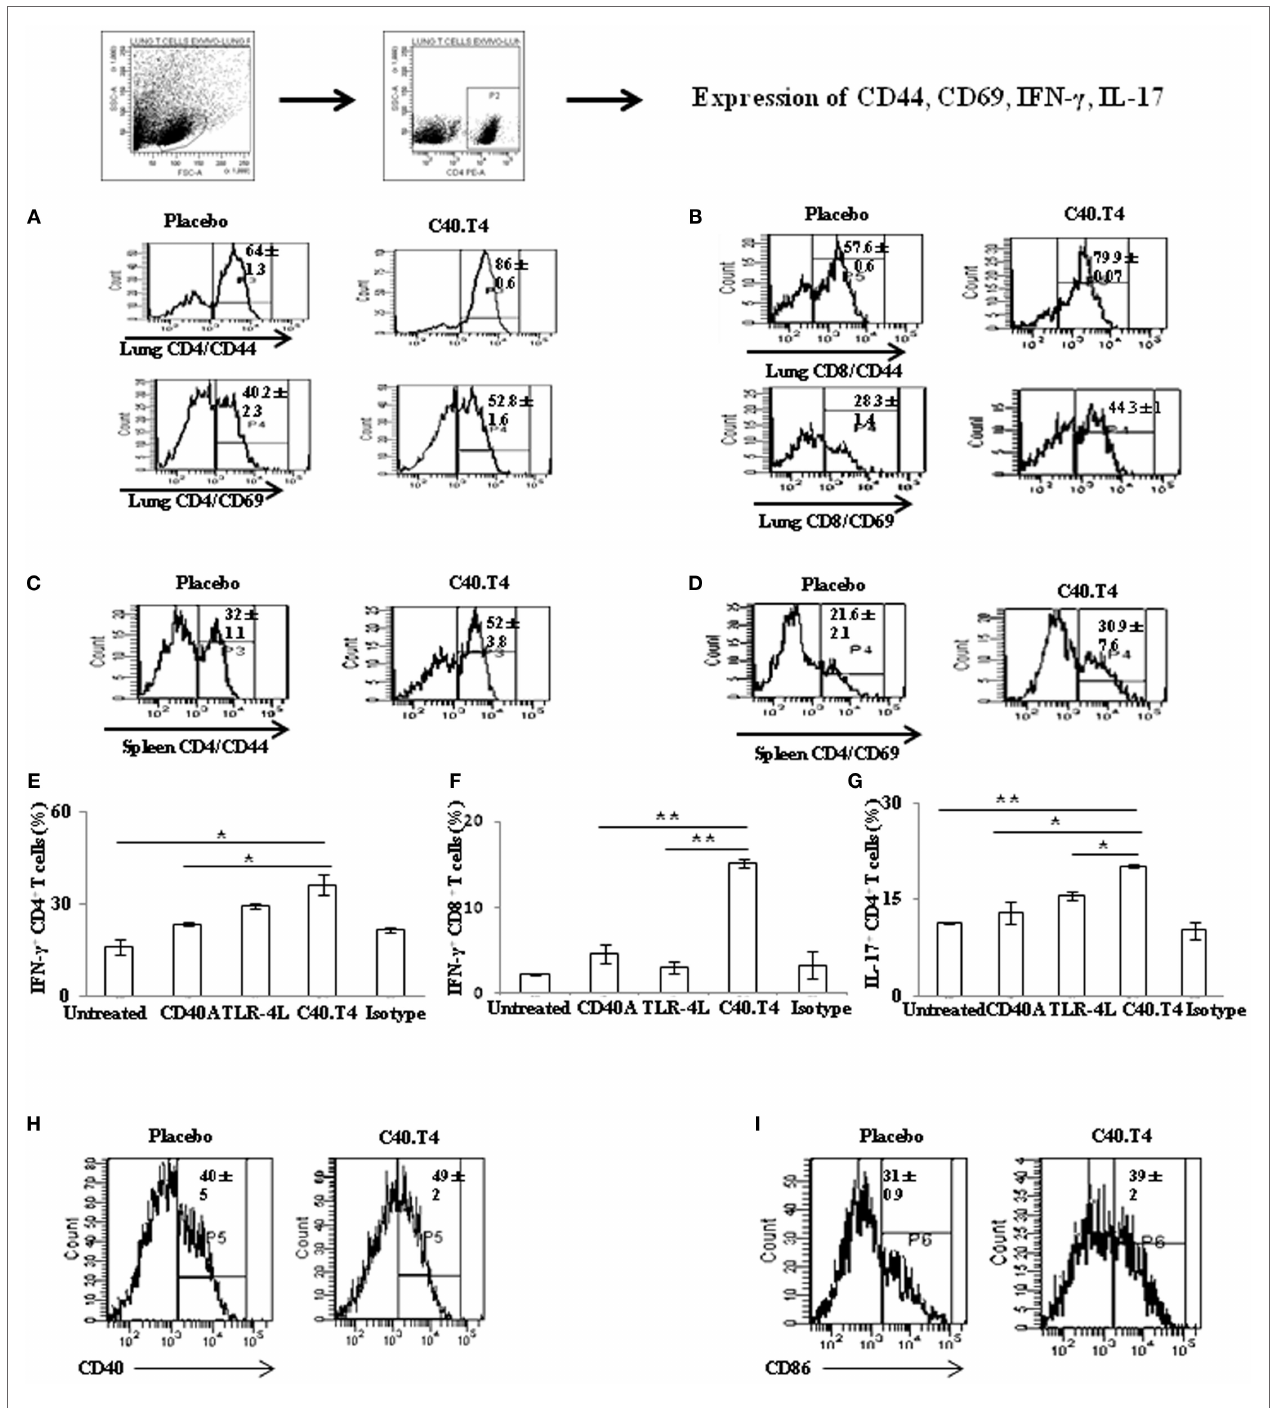
FigUre 7 | c40.T4 treatment bolstered the T cells immunity in mice exposed to Mtb . Mtb -infected animals were administered C40.T4. After 50 days, mice were sacrificed and lymphocytes were isolated and cultured with purified protein derivative (6 μ g/ml) for 48 h. Later, cells were stained for the expression of (a) CD44/CD69 on CD4 T cells isolated from the lungs; (B) CD44/CD69 on CD8 T cells isolated from the lungs; (c,D) CD44/CD69 on CD4 T cells isolated from the spleens. Number in the histograms indicates the percentage of CD44 hi and CD69 hi on CD4 and CD8 gated population. Splenocytes stimulated in vitro with PPD were stained for expression of (e) IFN- γ on CD4 T cells; (F) IFN- γ on CD8 T cells; (g) IL-17 on CD4 T cells. The bar diagrams illustrate percent population and results expressed as mean ± SD. DCs isolated from the lungs of Mtb -infected animals treated with C40.T4 were stained for the expression of (h) CD40; (i) CD86 and on CD11c + DCs. Number in the histogram indicates the mean ± SD of CD11c + DCs expressing CD40 and CD86 population. The data are representative of two independent experiments ( n = 4 mice/group). “*,” “**,” and “***” indicate p < 0.05, p < 0.01, and p < 0.001, respectively.